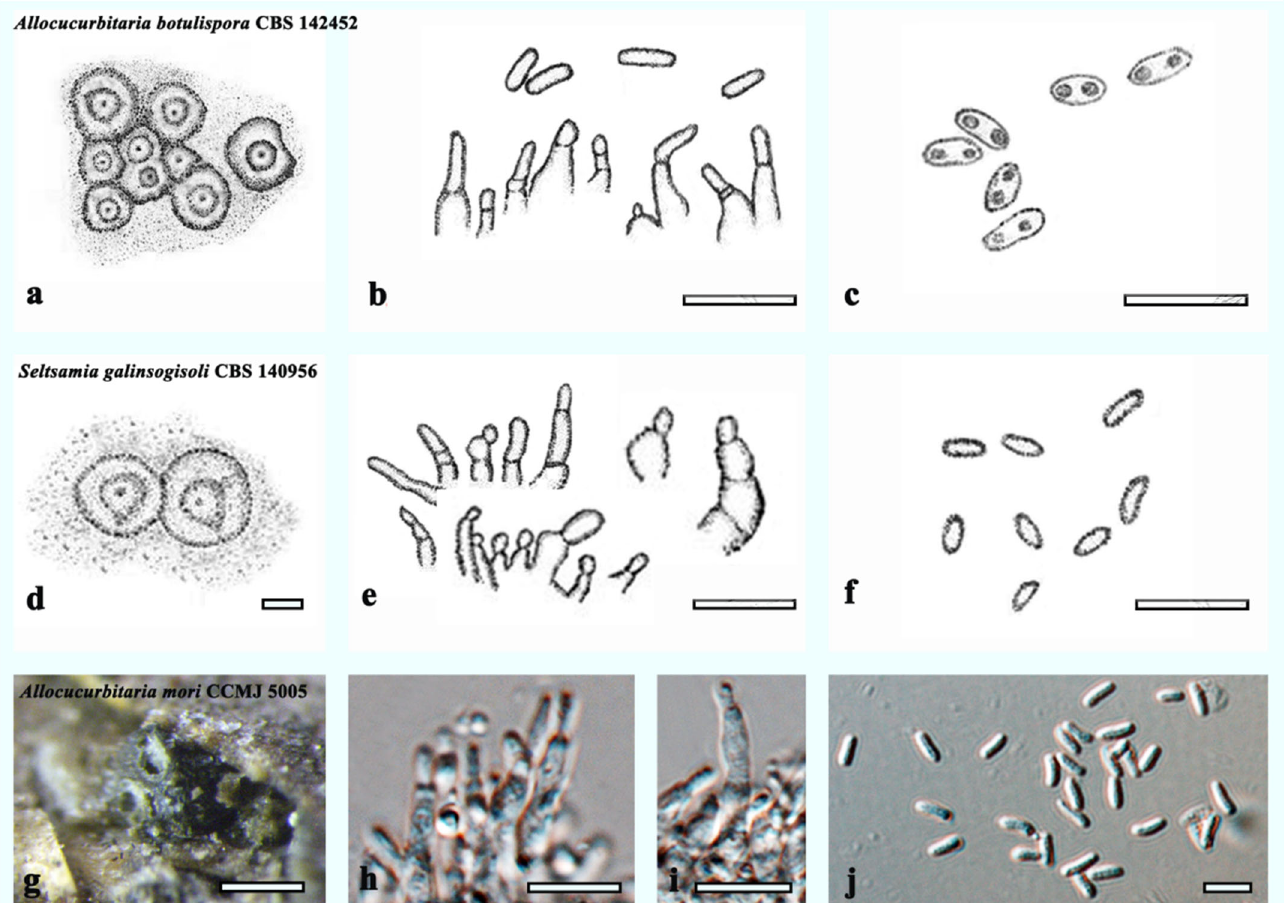
Figure 4. Morphology of related taxa in the Allocucurbitaria clade. ( a – c ) Characters of Allocucurbitaria botulispora were redrawn from Valenzuela-Lopez et al. [41]: ( a ) Pycnidia. ( b , c ) Conidiogenous cells and conidia. ( d – f ) Characters of Seltsamia galinsogisoli redrawn from Zhang et al. [42]: ( d ) Pycnidia. ( e , f ) Conidiogenous cells and conidia. ( g – j ) Characters of Allocucurbitaria mori (CCMJ 5005): ( g ) Ap- pearance of conidiomata of Allocucurbitaria mori on host substrate. ( h – j ) Conidiogenous cells and conidia. Scale bars: ( b , c , e , f , h , i ) = 10 μ m; ( d ) = 20 μ m; ( g ) = 200 μ m; ( j ) = 5 μ m.